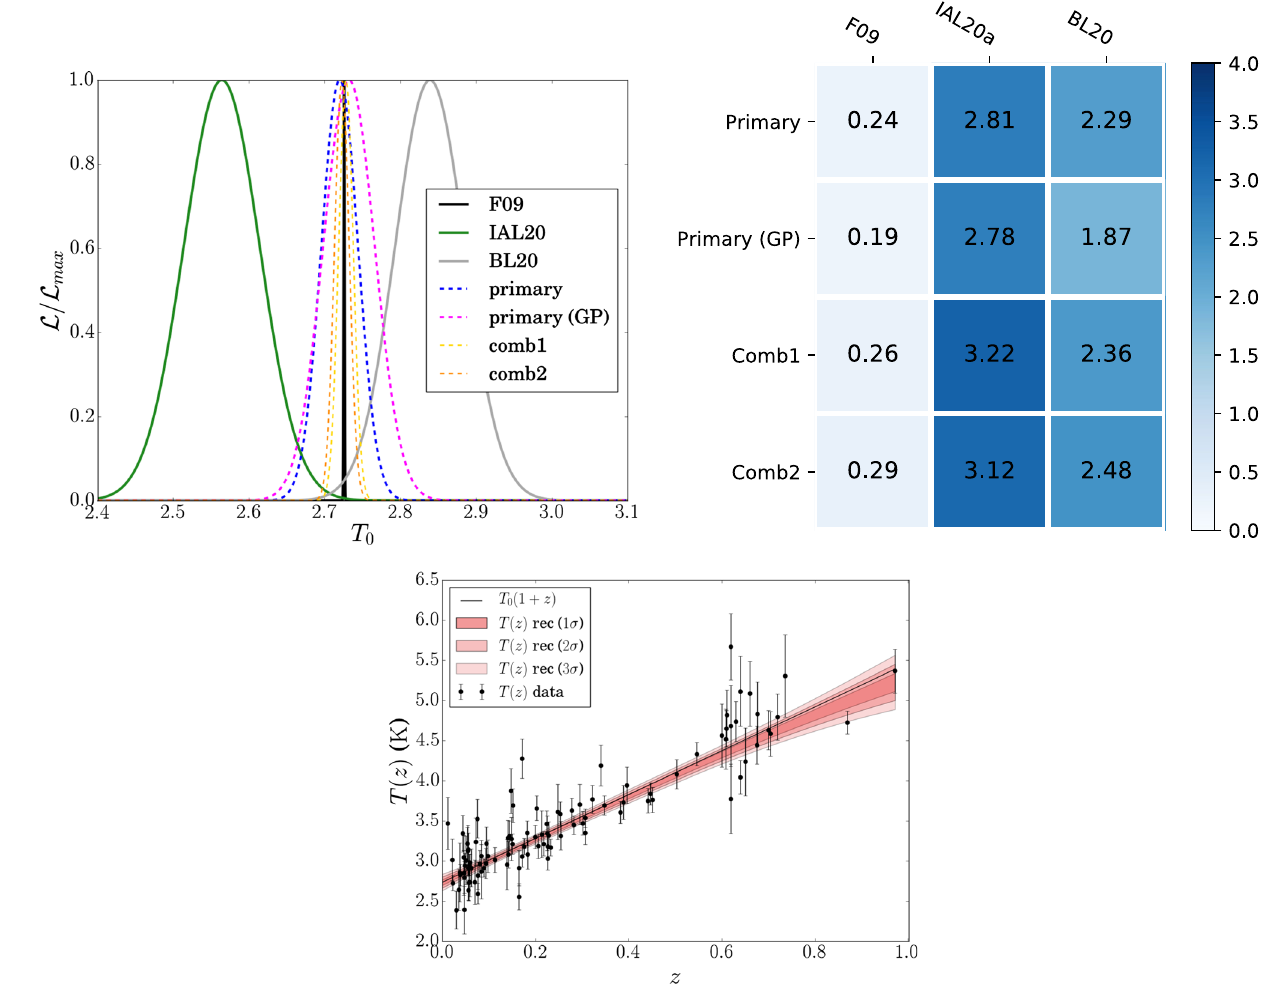
Fig. 1 Upper left panel The normalized T 0 likelihoods of F09 (black), IAL20 (dark green), BL20 (dark gray), plotted against the T 0 measure- ments obtained for each data-set (primary in blue, comb1 in golden, comb2 in dark orange). We also plot the result obtained for the pri- mary data-set using GP, as displayed in magenta Upper right panel A